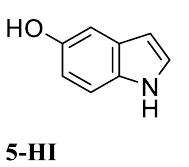
Figure 3. Structure of the first type I PAM discovered.